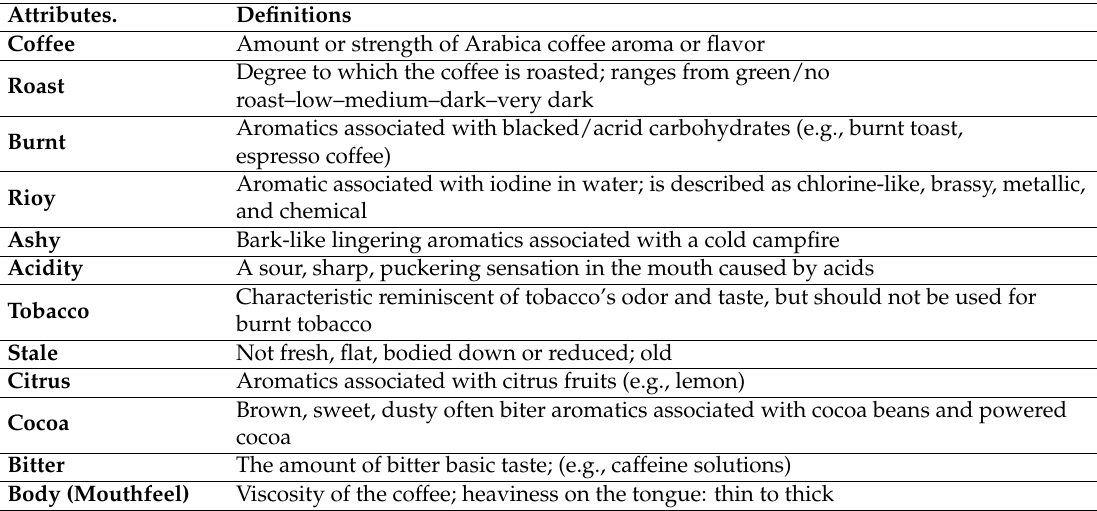
Table 1. The list of aroma, flavor, and texture descriptors identified by the coffee panel.